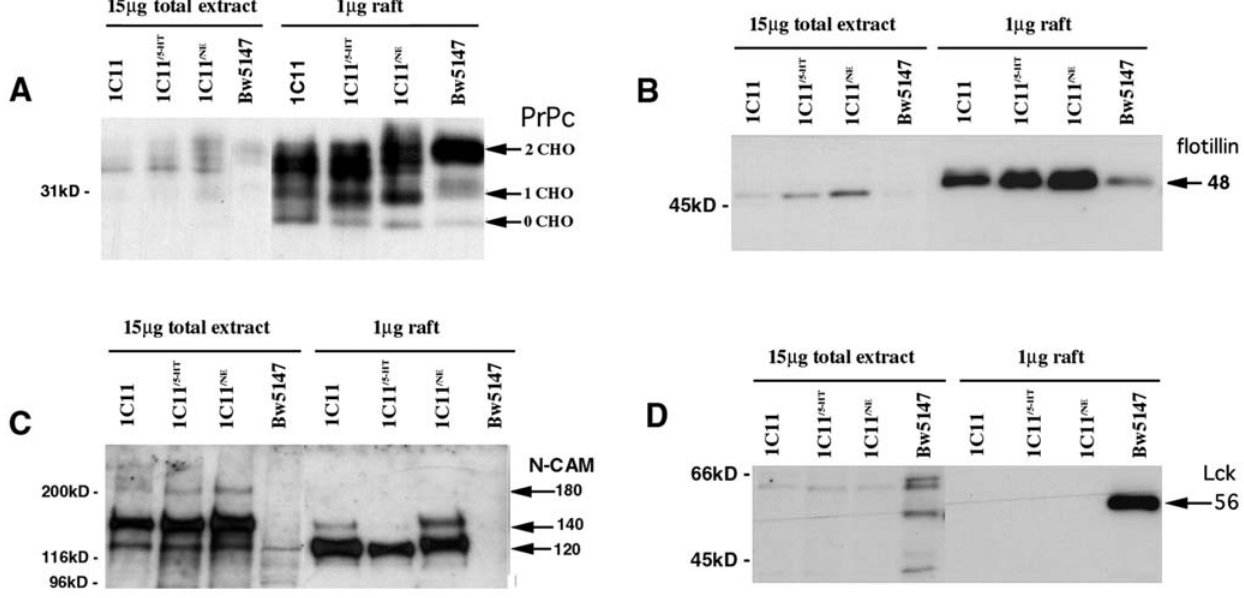
Figure 2. PrP C is enriched in lipid rafts irrespective of the differentiated state of 1C11 cells. Proteins of total extracts (15 m g) and lipid rafts (1 m g) from 1C11 cells, their neuronal 1C11 5-HT and 1C11 NE derivatives, and Bw5147 lymphoid cells (used as control) were resolved by 12% SDS- PAGE and analyzed by Western blot. Detection of PrP C (A) and other raft markers, i.e. flotillin (B), the NCAM isoforms (C) and Lck kinase (D). A 100- to 200-fold increase in the amount of PrP C , flotillin and the GPI-anchored 120 kDa isoform of NCAM was observed in GSL fractions in 1C11 cells whatever their differentiation state. As expected, Lck kinase, was only present in lipid rafts of lymphoid cells. Of note, the B, C and D panels were obtained by stripping and reprobing the same blotted nitrocellulose